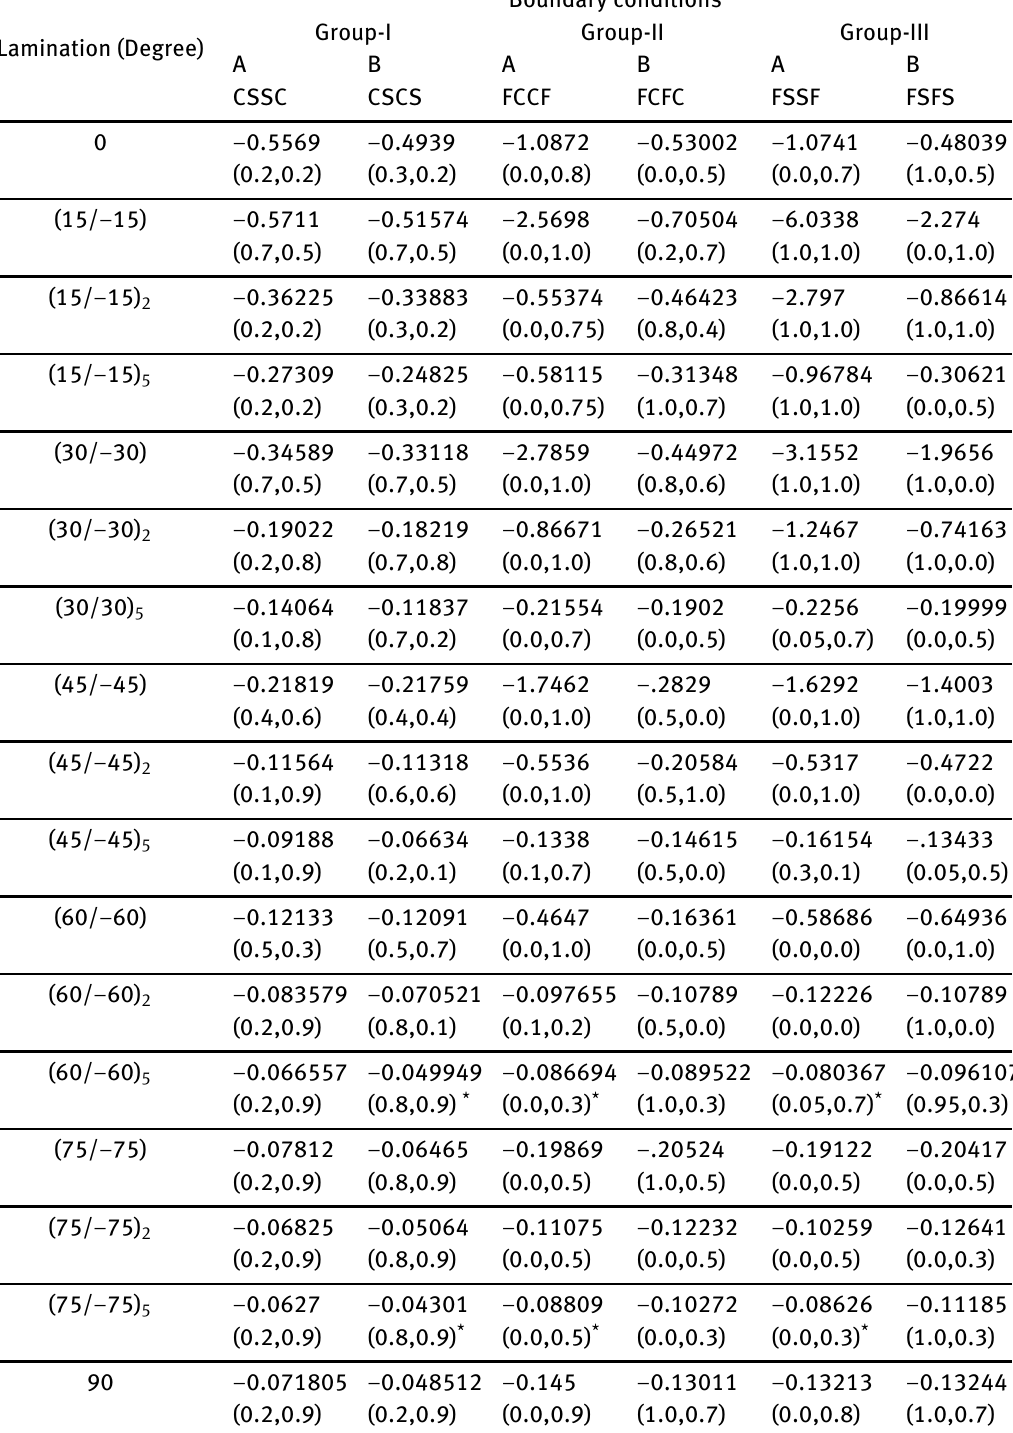
Table 13: Values of maximum non-dimensional sagging moment (− M y ) x 10 2 for different antisymmetric angle ply lamination and boundary conditions of stiffened composite hypar shell with